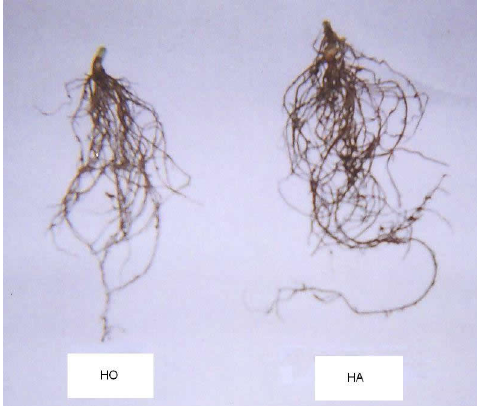
Fig. 2. Vicia faba L. seeds at harvesting stage treated with HO: Hoagland and HA: Humic